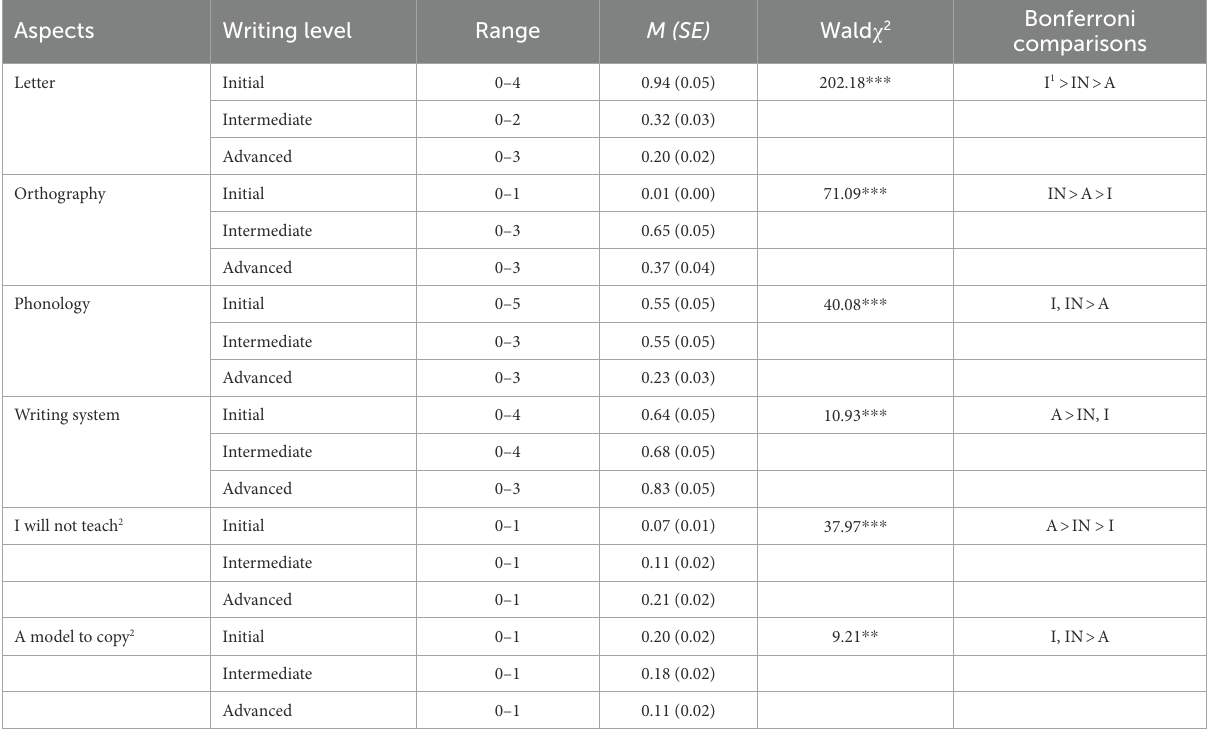
TABLE 2 Differences in the sum of parents’ writing support recommendations for the different writing levels ( N = 274).